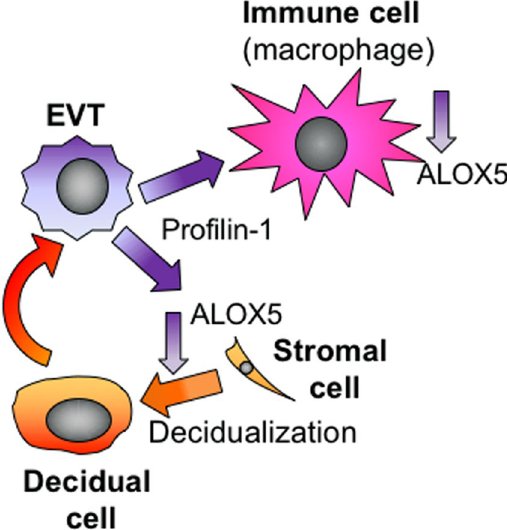
Figure 6. EVT-decidual-immune cell interaction. EVT-HESC synchrony and cross-talk is critical for implantation during early pregnancy. Decidualized HESC factors promote EVT secretion of profilin 1, which acts to promote stromal cell decidualization via the down-regulation of ALOX5. EVT-secreted profilin 1 also down-regulates ALOX5 in macrophages where it likely regulates cytokine